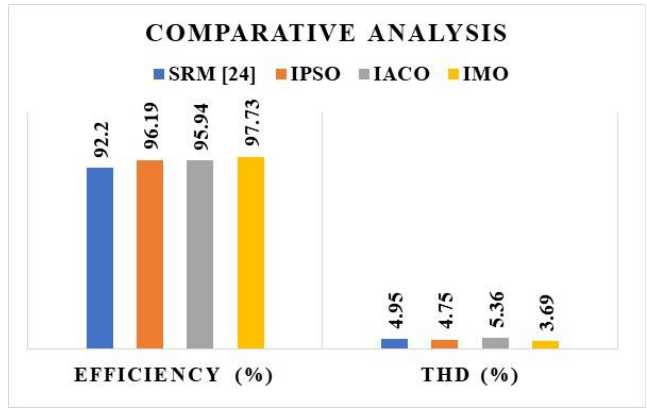
Figure 13. THD analysis of IMO controller.